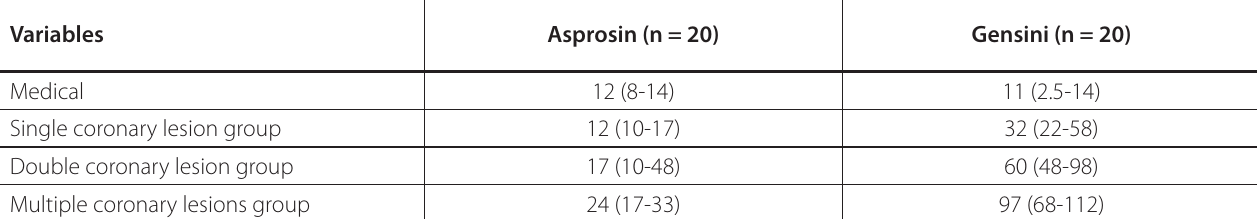
Table 3 . Asprosin and Gensini score values/median (min-max).